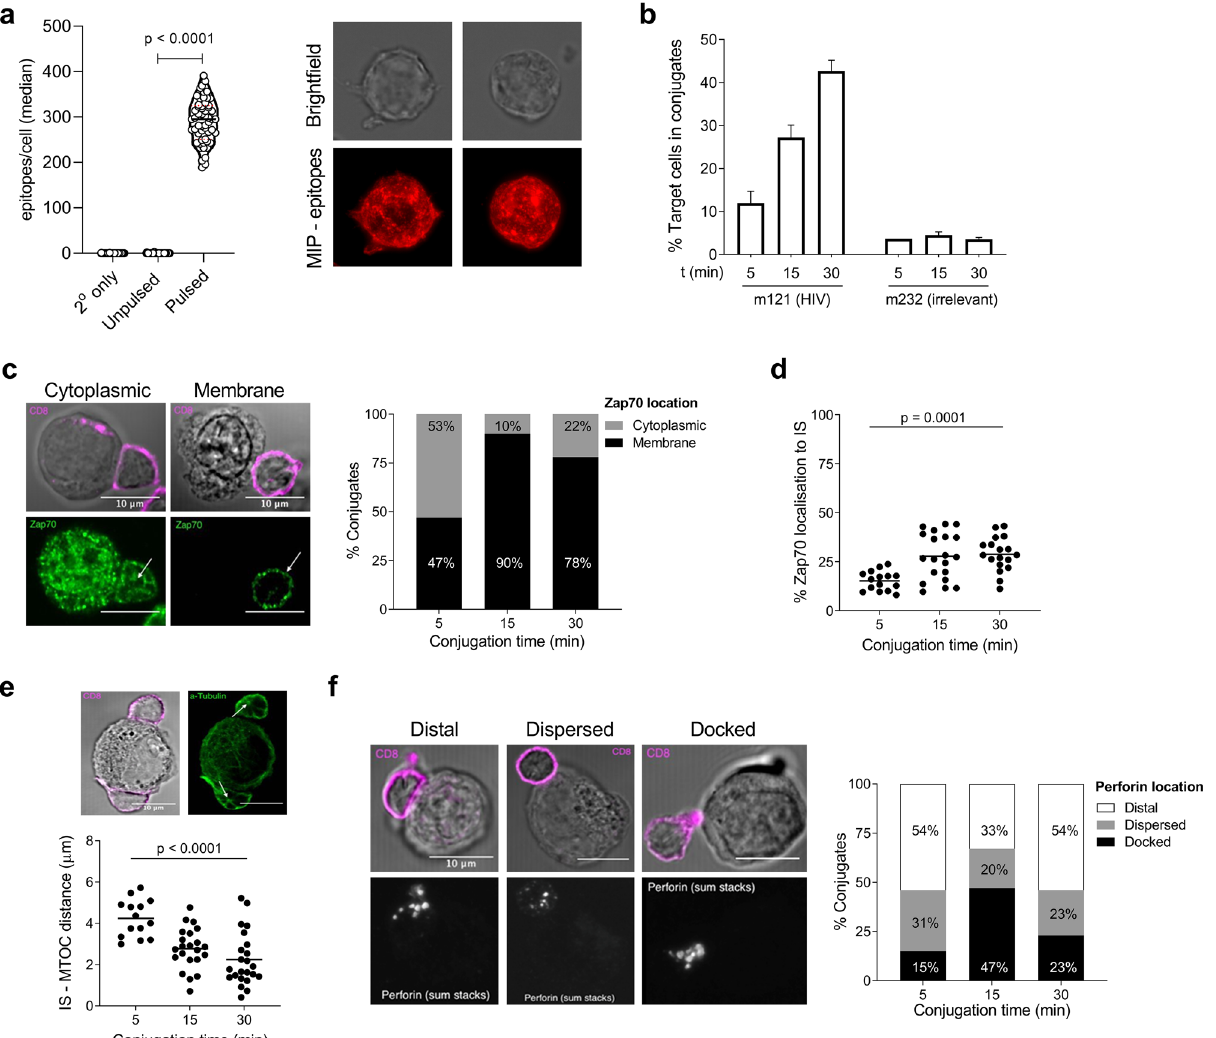
Figure 2. Time course of immunological synapse (IS) formation by ImmTAV-redirected HIV-naïve donor CD8 + T cells. SL9-peptide pulsed T2s were ( a ) stained for surface epitopes using a labelled TCR and imaged by TIRF microscopy for epitope/cell quantification (brightfield and maximum intensity projection (MIP) of labelled TCR shown; one dot represents one cell). These targets were then co-cultured with HIV-naïve donor CD8 + T cells (E:T of 1:1) for 5, 15 or 30 min before confocal microscopy imaging and analysis. ( b ) % of target cells in conjugates with CD8 + T cells over time in the presence of HIV-specific ImmTAV (m121, 0.5 nM) or irrelevant TCR-anti-CD3 fusion protein (ImmTAX, m232, 1 nM). C-F all show IS formation in the presence of the HIV ImmTAV, m121. ( c ) Representative confocal images of conjugates showing CD8 + T cell Zap70 (green) localisation in the cytoplasm (left) or in the plasma membrane (right). The percentage of conjugates with Zap70 localised to the cytoplasm (grey) or membrane (black) was calculated at different conjugation times. ( d ) The percentage Zap70 localised at the IS in CD8 + T cells. ( e ) Confocal images of α-tubulin (green) to define MTOC location (indicated with white arrow) and distance from IS to MTOC (μM). ( f ) Confocal microscopy images of perforin staining (summed Z stack shown in white) and % conjugates with distal, dispersed or docked perforin in the CD8 + T cells. For D & E each dot represents one T2-CD8 + T cell conjugate (0.5 nM m121 for c – f ); 1 slide (representing 1 donor) was analysed per time-point; magenta = CD8 on differential interference contrast image (DIC). Means shown and data were analysed by one-way ImmTAV molecules enable polyclonal CD8 + T cells from PLWH to form lytic immune syn- apses. To further probe the functionality of PLWH CD8 + T cells, we next assessed their capacity to form IS with peptide pulsed T2 cells when redirected by an HIV ImmTAV. Imaging of the pulsed T2 cells after staining with the same HIV TCR, in a biotinylated and fluorescently tagged format, confirmed that the target cells had a high number of peptide-HLA for recognition by the HIV ImmTAV (median 295 epitopes/cell, Fig. 2a), thus confirming their utility as ‘model antigen-presenting cells’ for investigation of ImmTAV-mediated IS formation. The experimental conditions for observation of IS by confocal microscopy were established using HIV-naïve